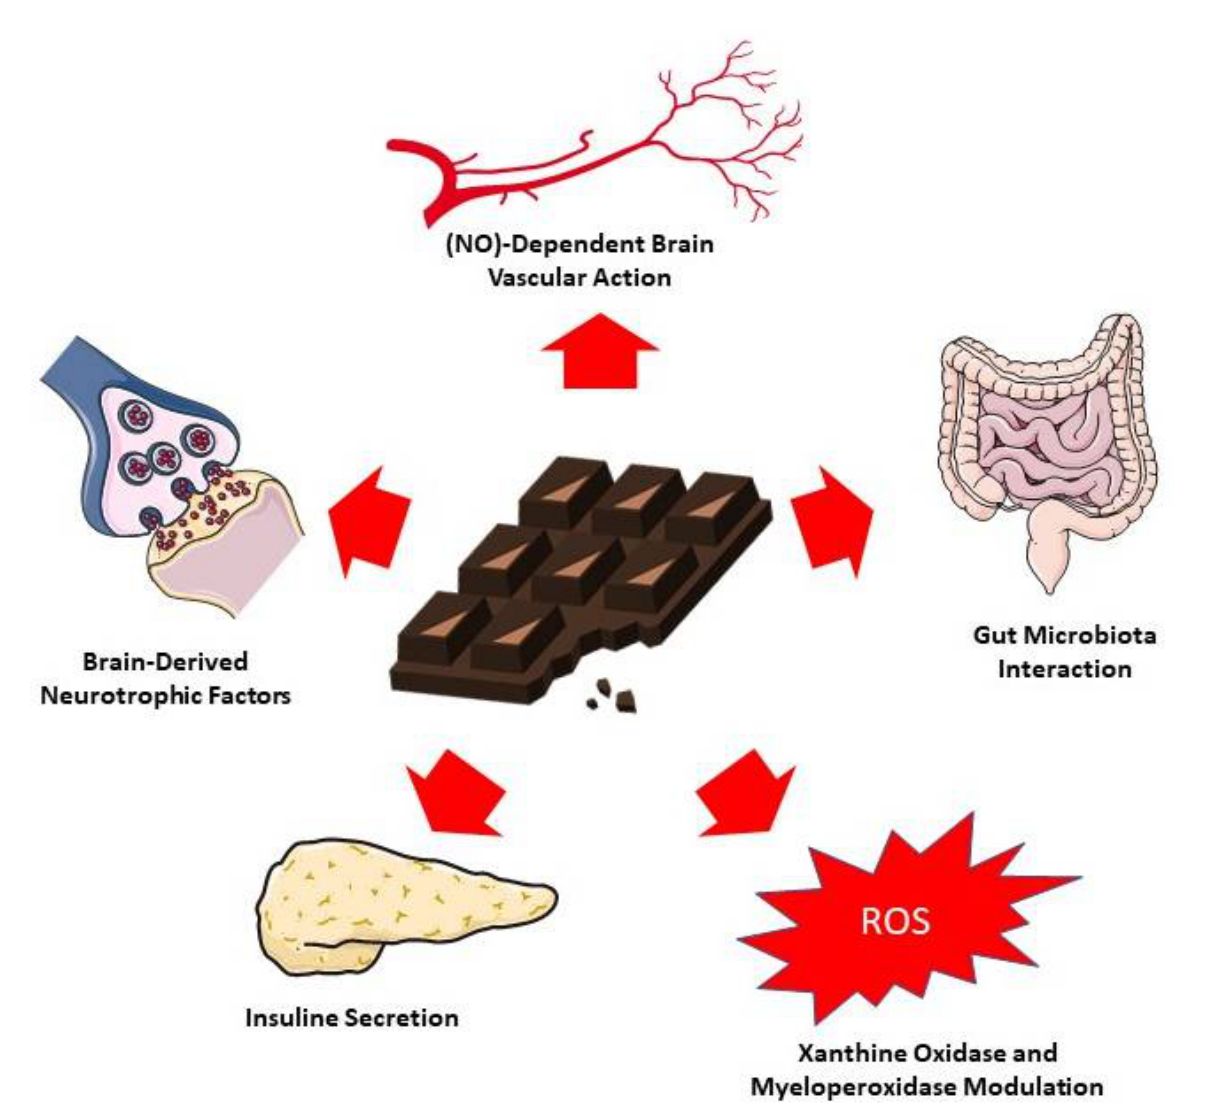
Figure 3. Proposed mechanisms for chocolate and cocoa action on cognition. The figure was partly generated using Servier Medical Art, provided by Servier, licensed under a Creative Commons At- tribution 3.0 unreported license [108].